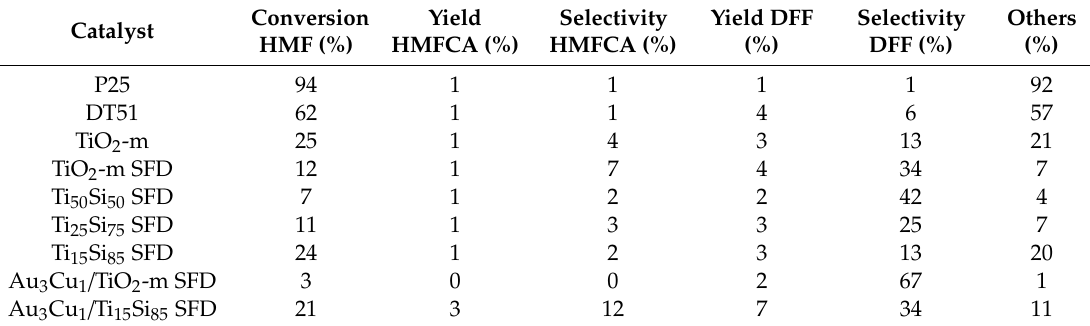
Table 2. Photocatalytic results of tested catalysts. Reaction conditions: t = 1 h, T = 30 ◦ C, P = 1 atm O 2